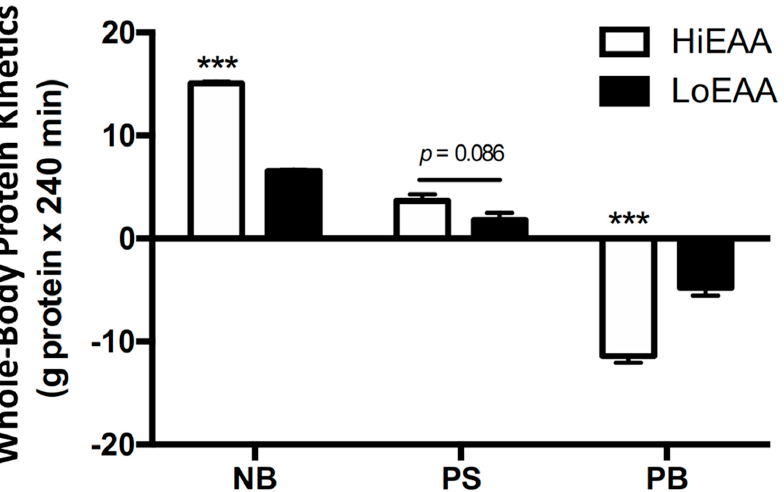
Figure 3. Total changes in whole-body protein kinetics (protein synthesis (PS), protein breakdown (PB), and net protein balance (NB)) from basal post-absorptive values following either the HiEAA or the LoEAA. *** Significantly di ff erent between meals, p < 0.001. Values ( n = 7) are expressed as mean ±